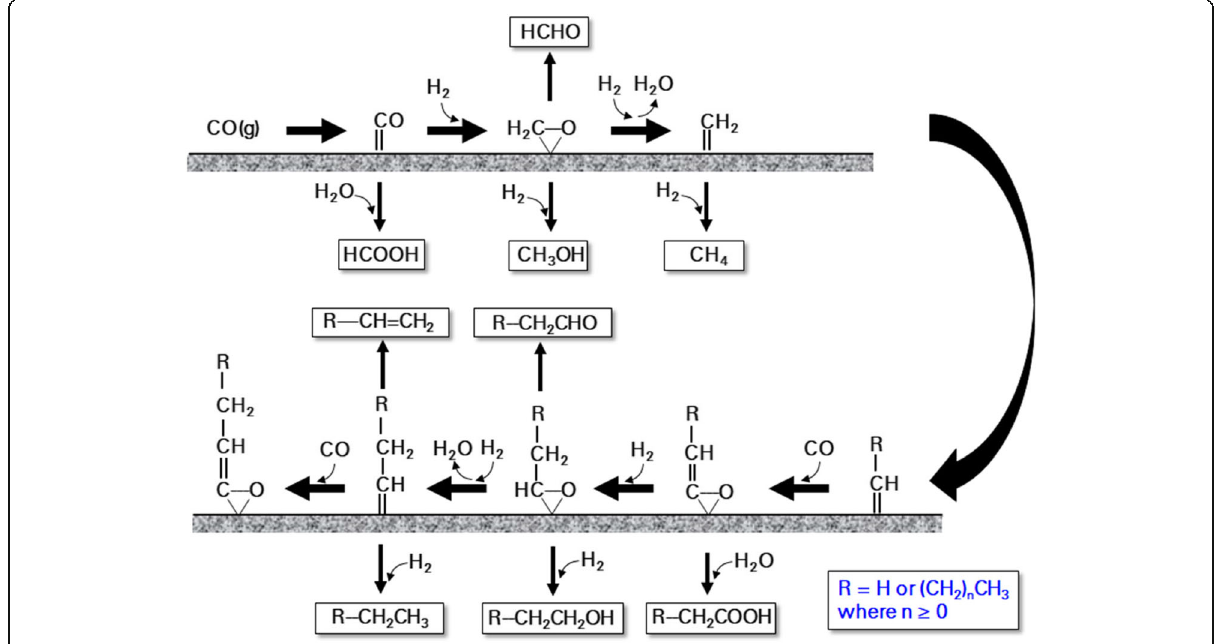
Fig. 7 Simplified Fischer-Tropsch reaction network based on an oxygenate mechanism